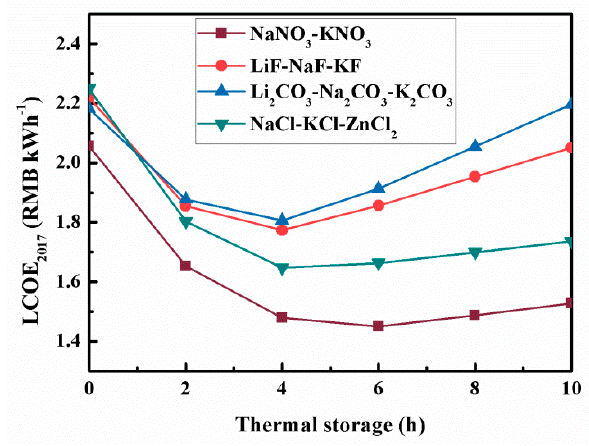
Figure 7. Influence of TES capacity on the LCOE for four different molten-salts.